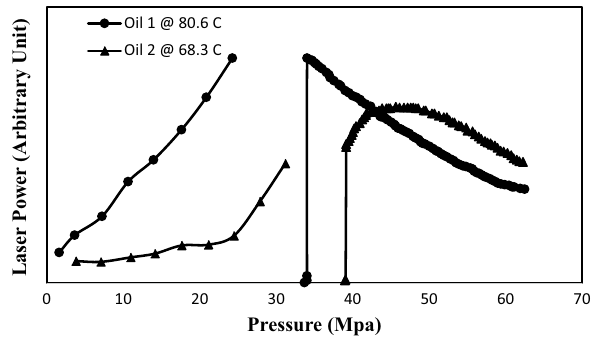
Fig. 27 Intensity of NIR light with respect to pressure for Oil 1 and Oil 2 (Hammami et al. 2000)